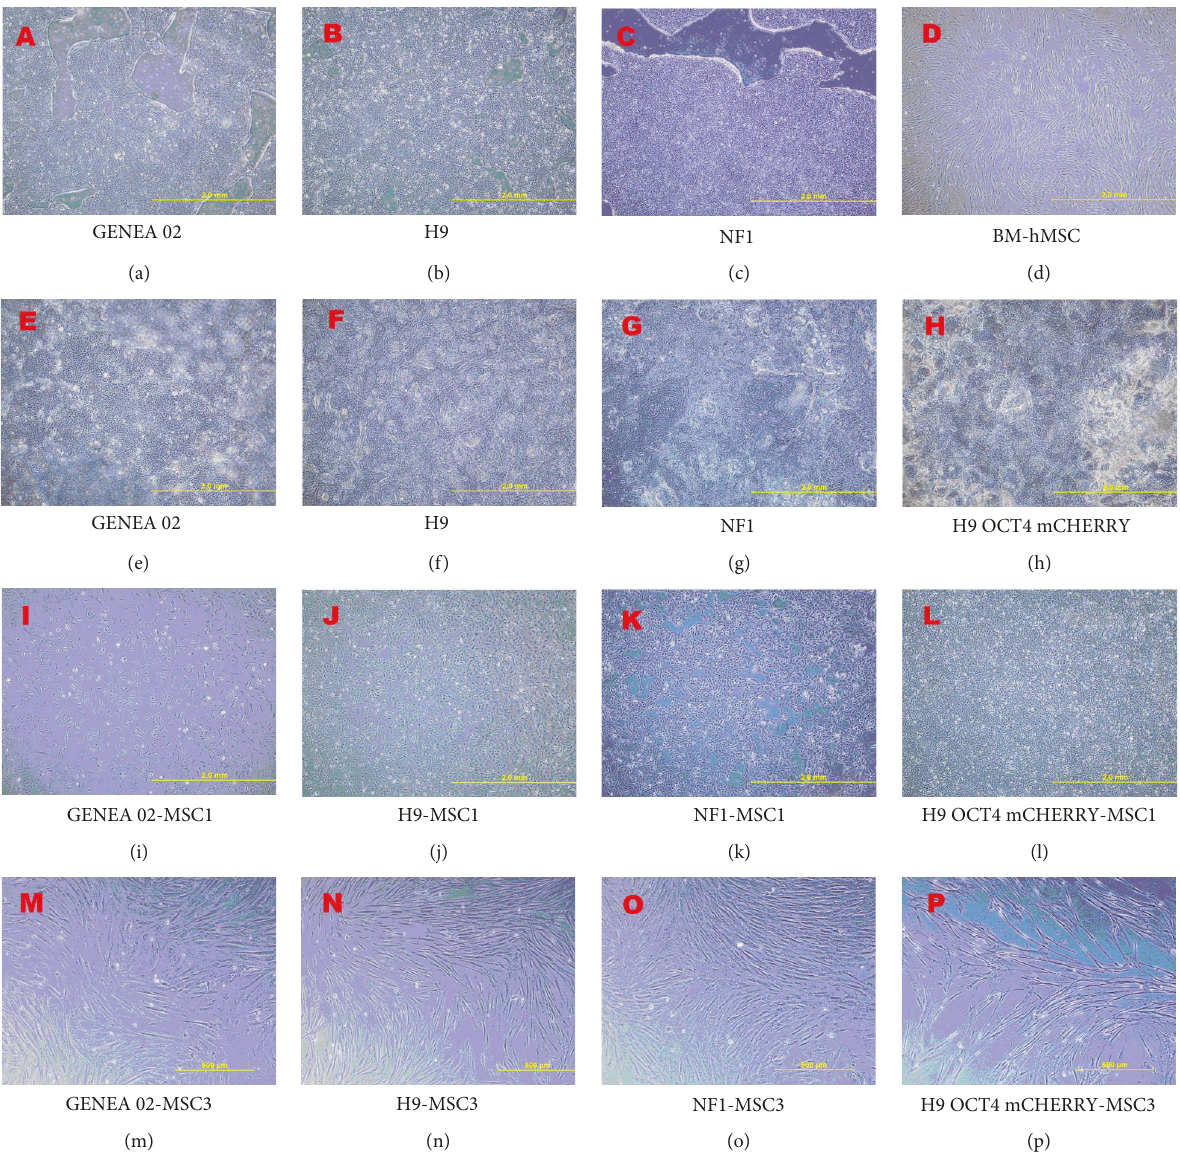
Figure 1: Morphological characteristics of GENEA 02, H9, NF1, and BM-MSCs before and during the di ff erentiation process. (a, b, c) Typical circular and fl at colonies with a well-de fi ned border observed in undi ff erentiated human embryonic stem cells and induced pluripotent stem cells before the di ff erentiation process. (d) Typical spindle-shaped morphology of bone marrow-derived human mesenchymal stem cells. (e, f, g, h) Regions of SB-induced di ff erentiation were apparent as cells develop an enlarged, fl attened epithelial-like morphology in a circular conformation after 10 days of SB431542 exposure. (i, j, k, l) An intermediate morphology was observed on GENEA 02-MSC1, H9-MSC1, and NF1-MSC1 cells while H9 OCT4 mCHERRY-MSC1 still appeared as large and fl at cells after one passage in MPC Growth MEM media. (m, n, o, p) A spindle-shaped morphology similar to that of BM-hMSCs was observed in all cell lines examined after three passages in MPC Growth MEM